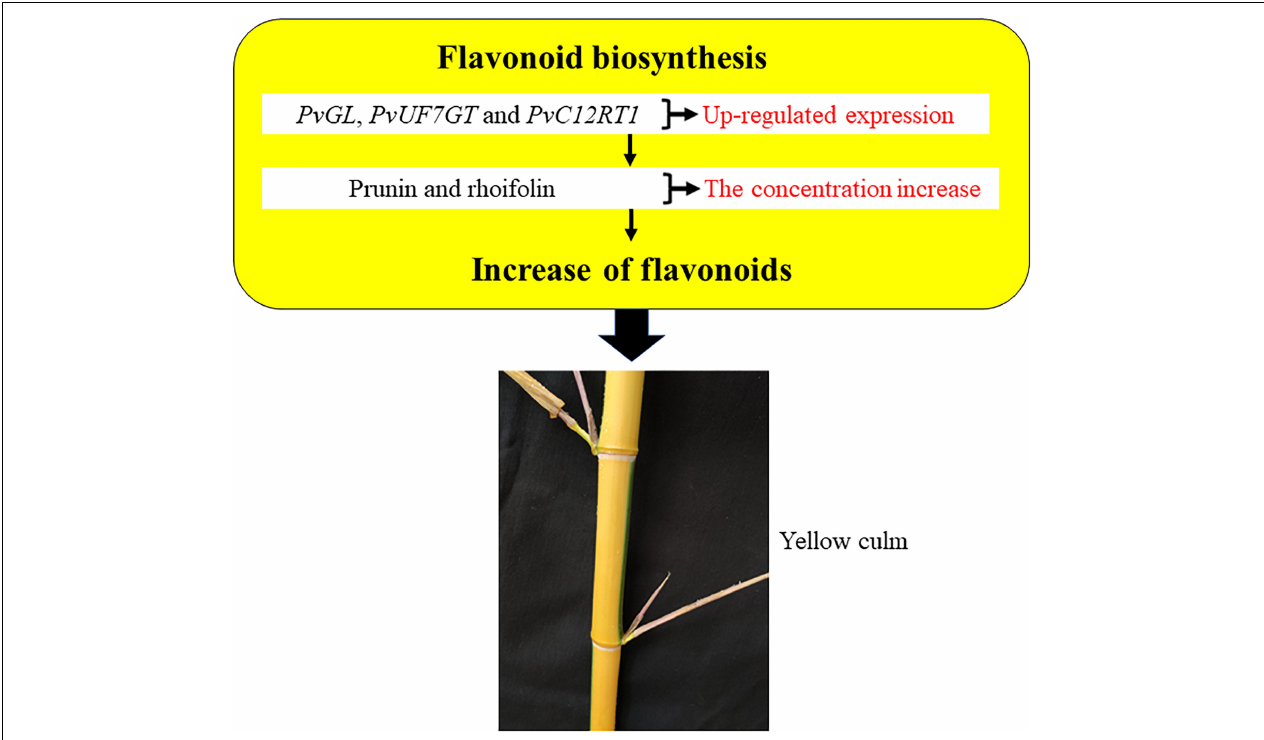
FIGURE 4 | A model for flavonoid-mediated regulation of bamboo internode color